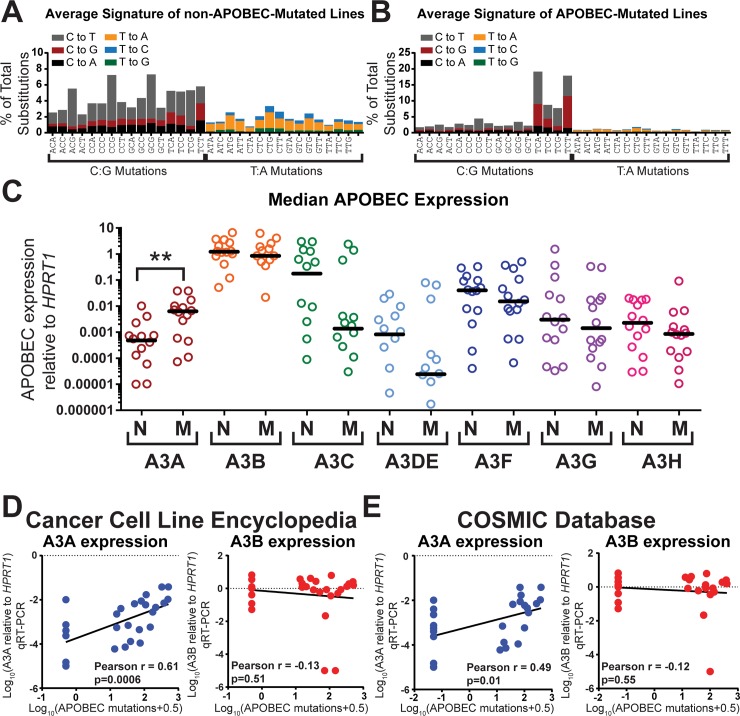
APOBEC3A mRNA transcript levels correlate with the extent of APOBEC-induced mutations in BRCA cell lines.The average mutation profiles of (A) 14 non-APOBEC-mutated and (B) 14 APOBEC-mutated BRCA cell lines. Specific cell lines in each category are defined in S2 Table. (C) mRNA expression level of individual APOBEC3 family members relative to HPRT1 expression was measured by qRT-PCR in non-APOBEC-mutated (N) and APOBEC-mutated (M) BRCA cell lines. Similar results were obtained comparing APOBEC expression to TBP (S2 Table). Each circle represents the mean of 3 replicate measurements for an individual cell line. Horizontal bars indicate the median expression for each APOBEC3 family member among the non-APOBEC-mutated or APOBEC-mutated cell lines. Data points corresponding to cell lines without detectable expression of individual APOBECs are not shown on the graph but are included in the calculation of the median. Statistical significance for differences in the expression of a given APOBEC family member between non-APOBEC-mutated and APOBEC-mutated lines was assessed by Mann-Whitney Summed Rank test. ** indicates p = 0.0067. Correlations between A3A expression (blue dots) or A3B expression (red dots) measured by qRT-PCR and the minimum estimate of APOBEC-induced mutations for each of the 28 BRCA cell lines were determined by a Pearson correlation test using mutation lists obtained from (D) the Cancer Cell Line Encyclopedia and (E) the Catalogue of Somatic Mutations in Cancer (COSMIC).